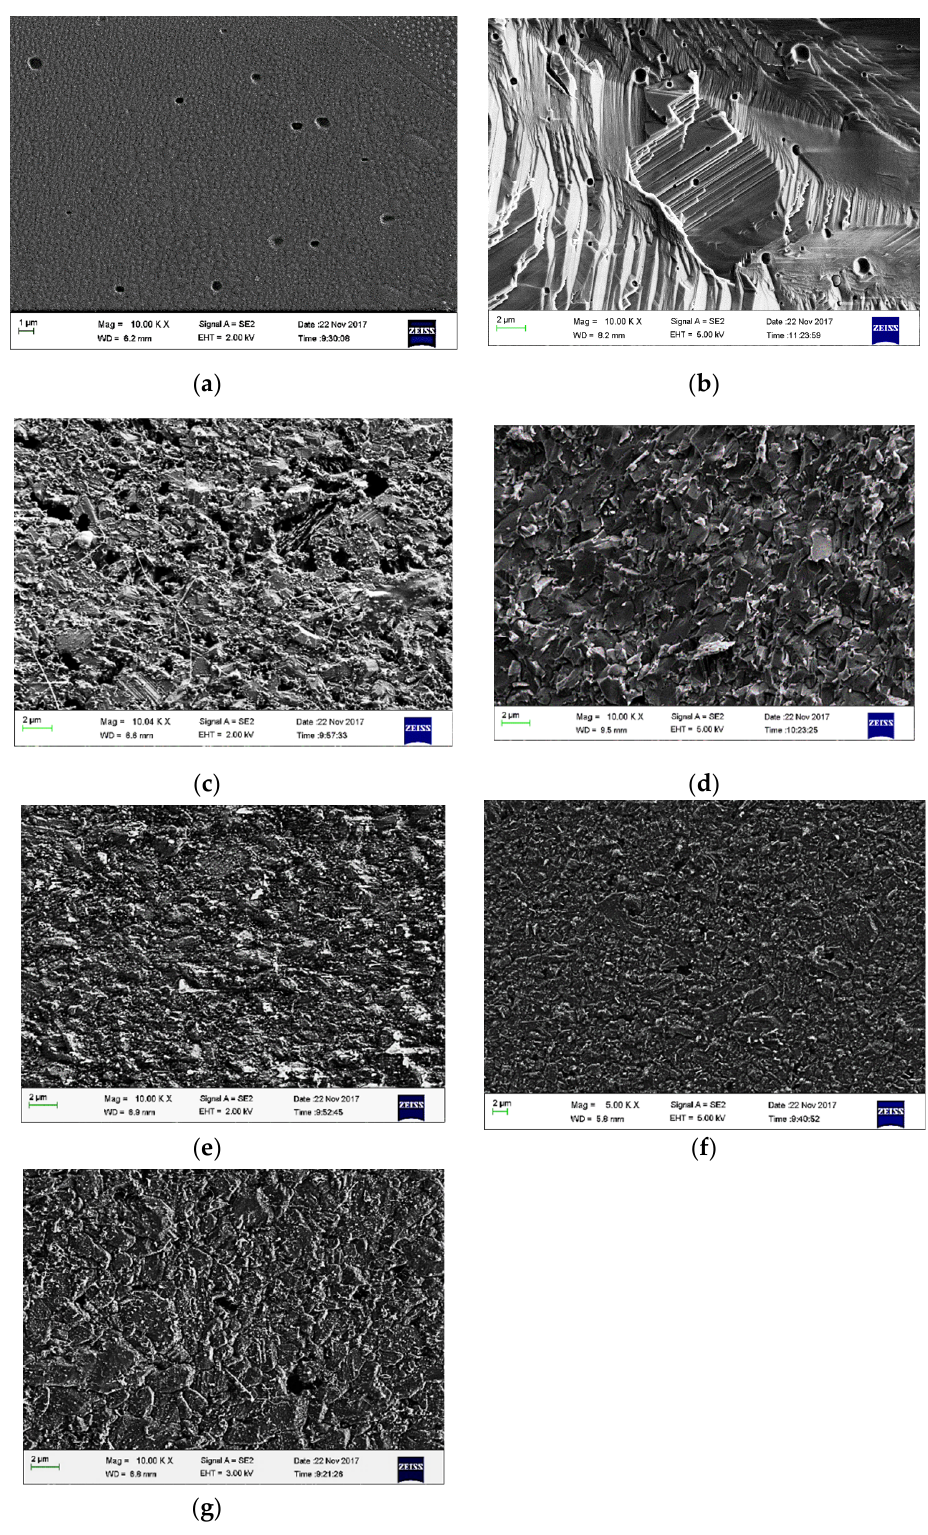
Figure 5. SEM secondary electron (SEM-SE) images of sintered ( a ) pure Al 2 O 3 ; ( b ) fractured surface of pure Al 2 O 3 ; ( c ) Al 2 O 3 -30SiC; ( d ) fracture surface of Al 2 O 3 -30SiC; ( e ) Al 2 O 3 -25SiC; ( f ) Al 2 O 3 -20SiC; ( g ) Al 2 O 3 -15SiC.